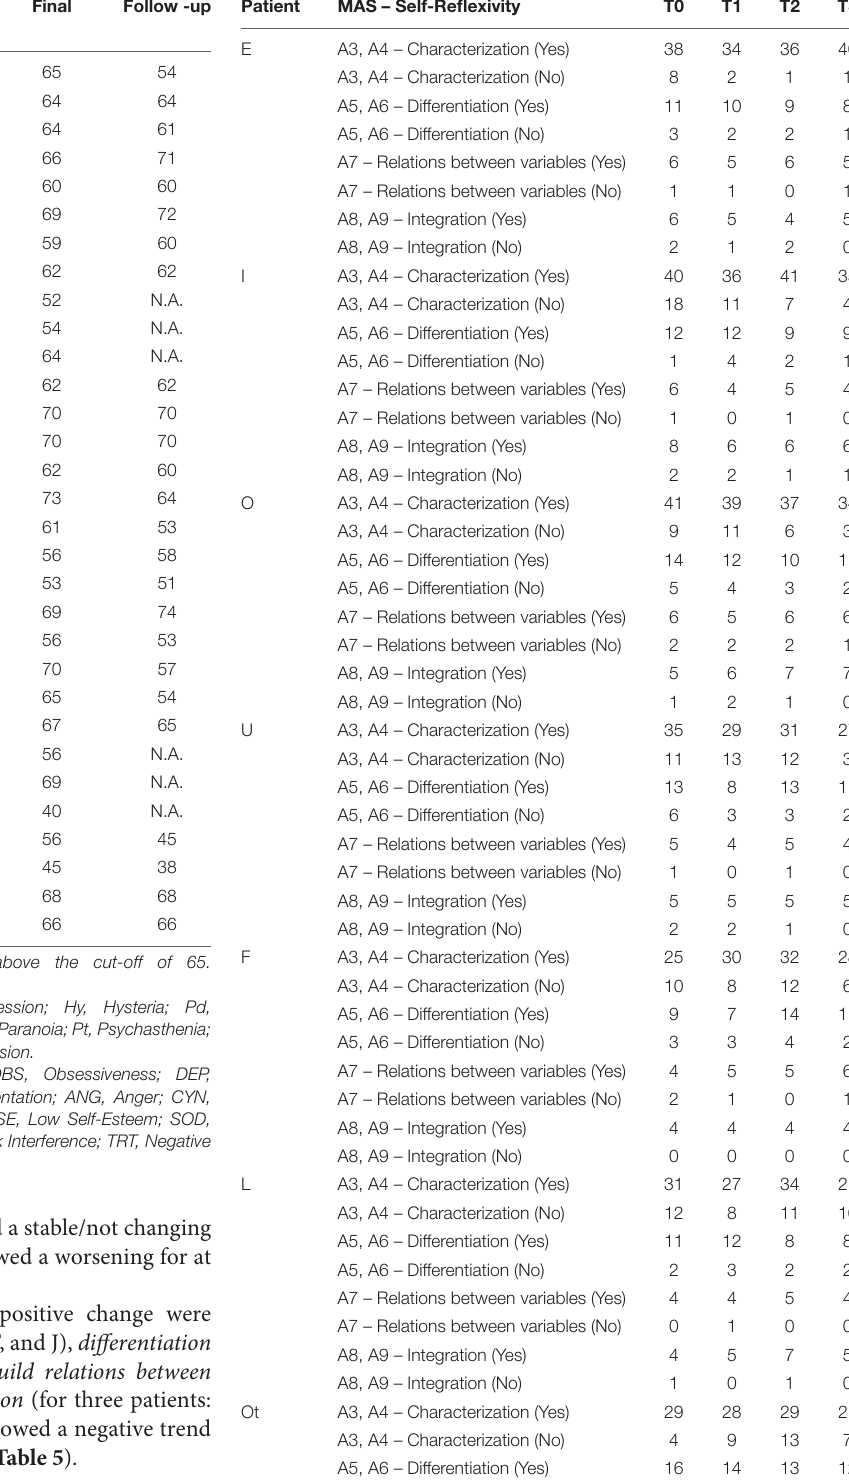
TABLE 4 | MMPI’S data at all three time points.